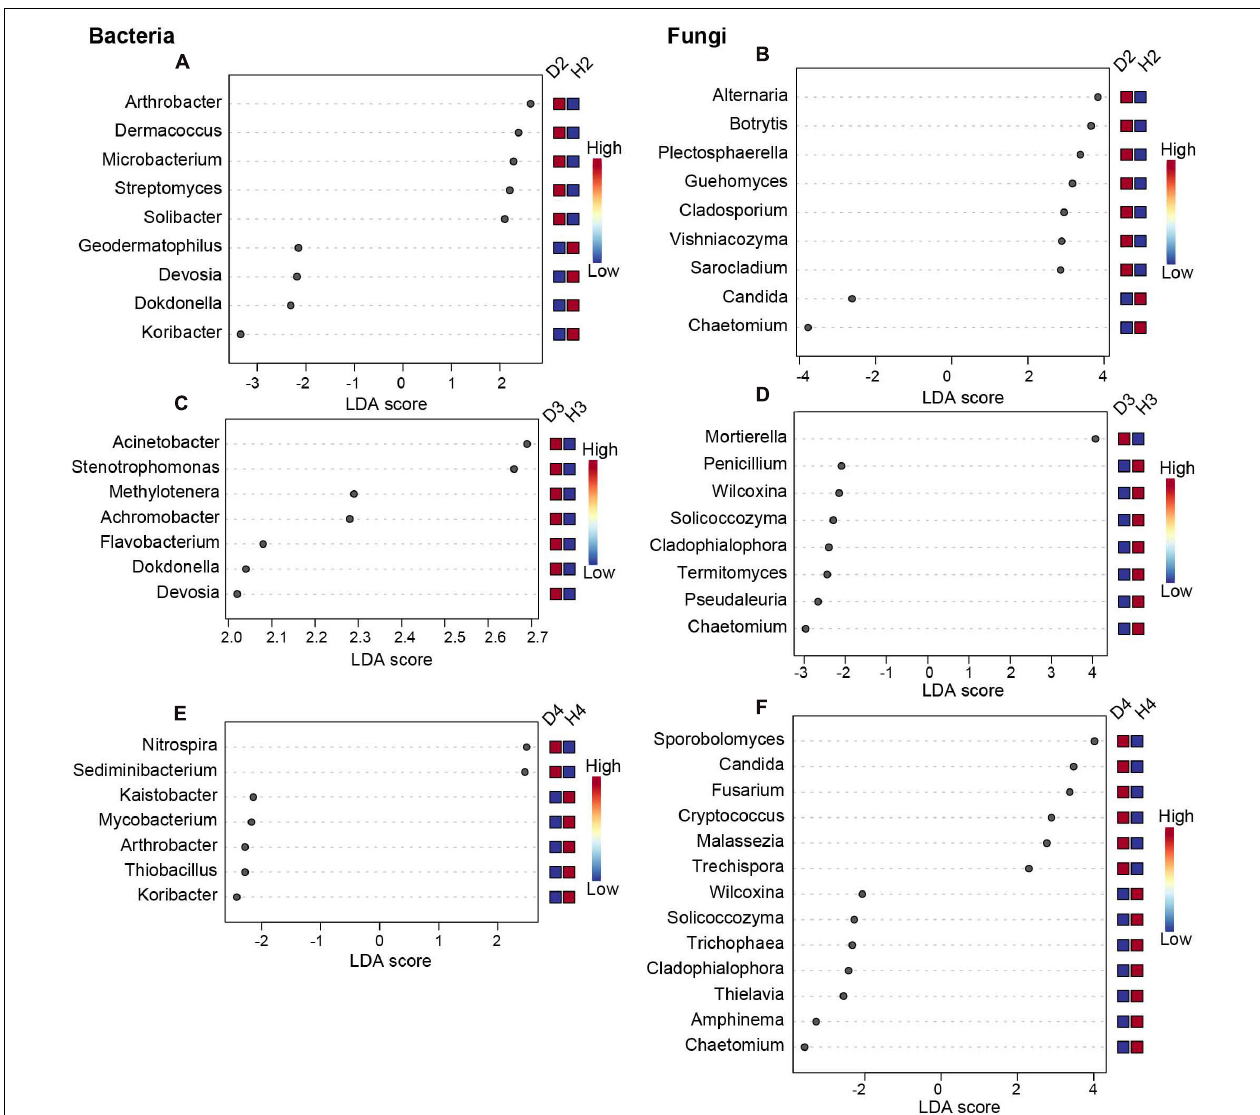
FIGURE 4 | Biomarkers of healthy and diseased AG microbiota at different plant ages, calculated using the LEfSe method. Only results with | LDA| > 2, P < 0.05, in Tukey’s honestly significant difference test are shown. (A,C,E) Represent the bacterial biomarkers in soil samples obtained from 2-, 3-, and 4-year-old AG plants, respectively, (B,D,F) , represent the fungal biomarkers in soil samples obtained from 2-, 3-, and 4-year-old AG plants, respectively. H2, soils obtained from 2-year-old healthy AG plants; D2, soils obtained from 2-year-old diseased AG plants; H3, soils obtained from 3-year-old healthy AG plants; D3, soils obtained from 3-year-old diseased AG plants; H4, soils obtained from 4-year-old healthy AG plants; D4, soils obtained from 4-year-old diseased AG